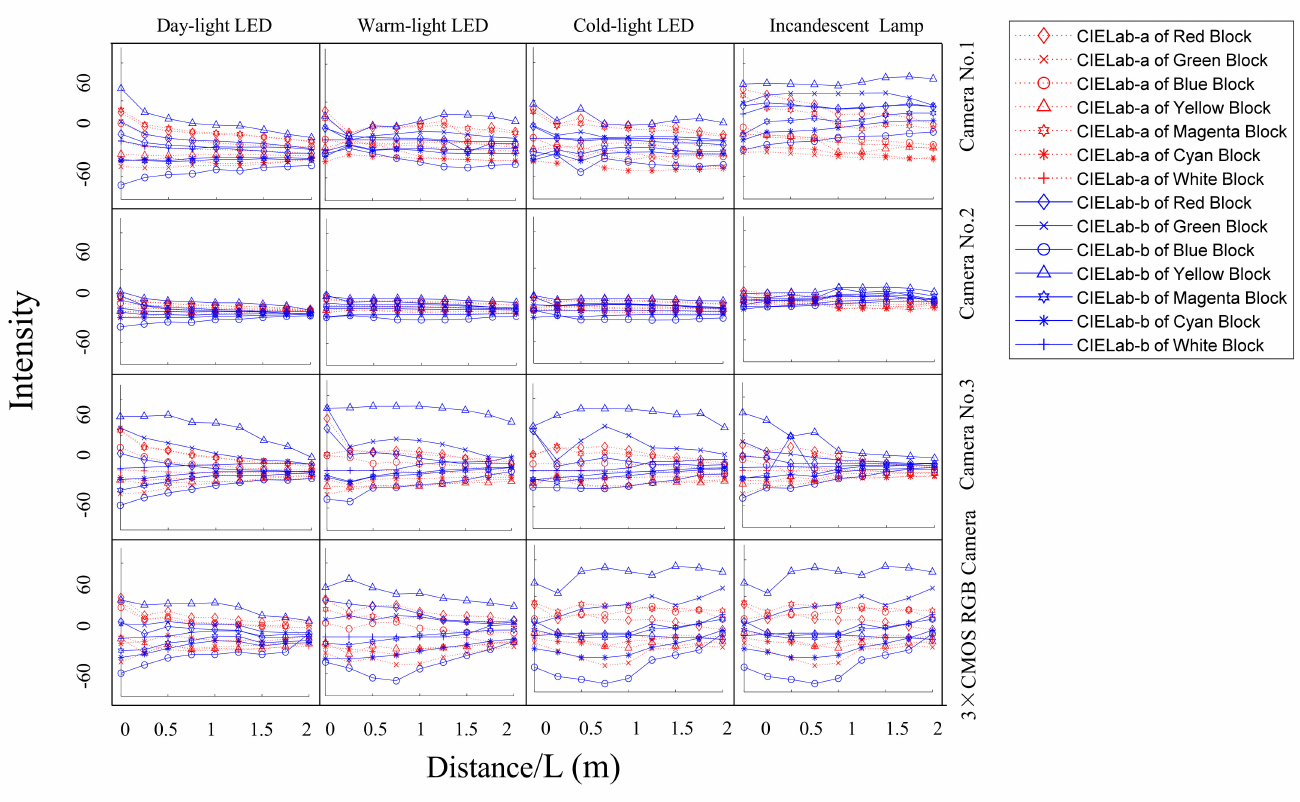
Figure 9. The values of a ∗ and b ∗ at different distances with different lamps and different